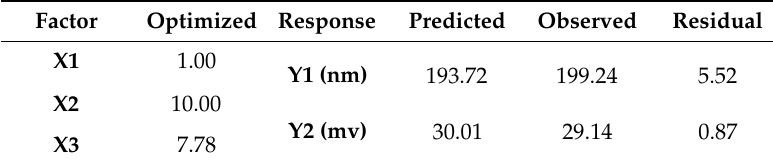
Table 3. Optimized calculated variables and observed, predicted, and residual values for responses (Y1 and Y2).